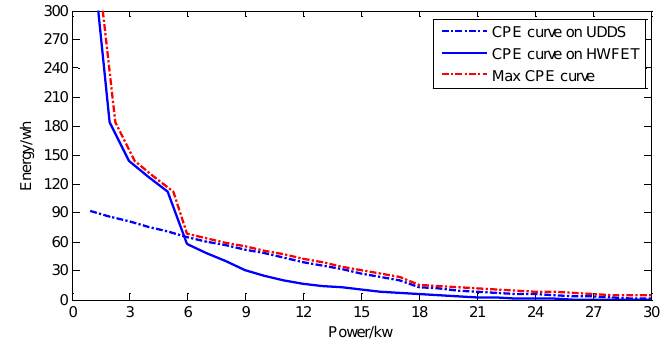
Figure 7. CPE curves on driving cycles.